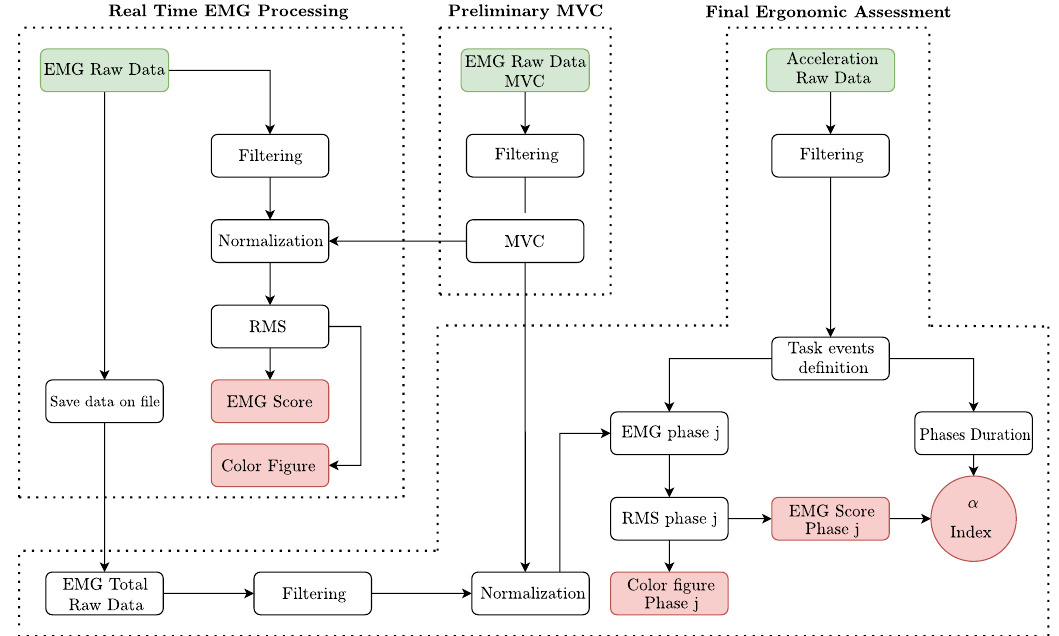
Figure 2. A flowchart showing all the steps implemented in the ergonomic